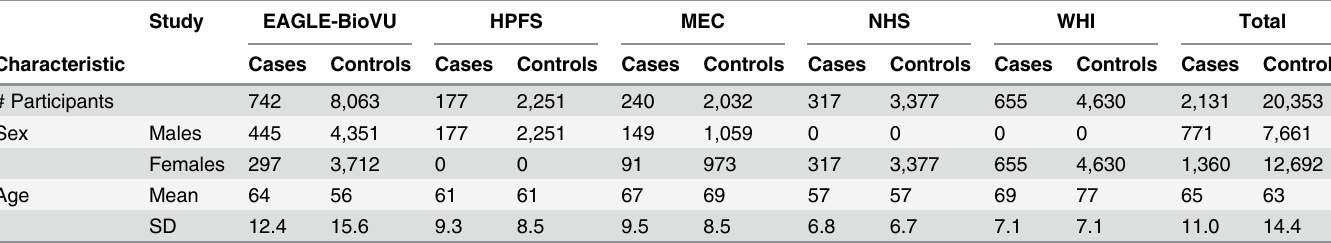
Table 1. Demographic characteristics of the fi ve studies contributing to this analysis.